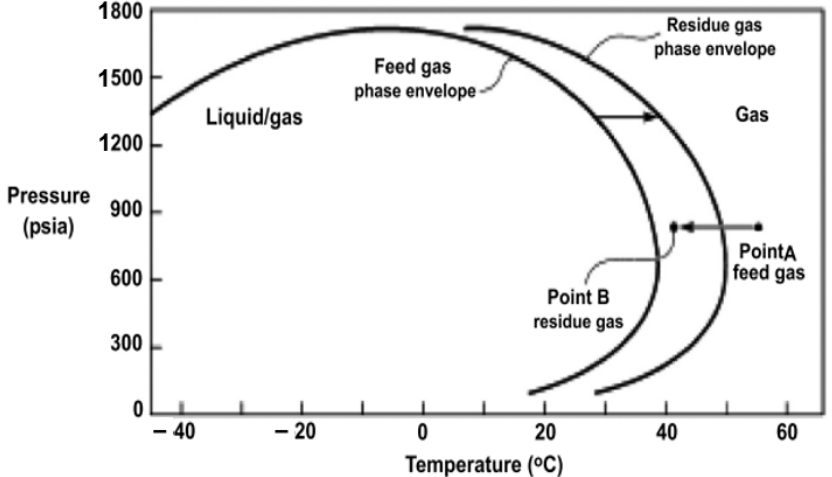
Figure 6. Graph displays the phase envelope change during natural gas processing by a CO 2 -selec- tive membrane